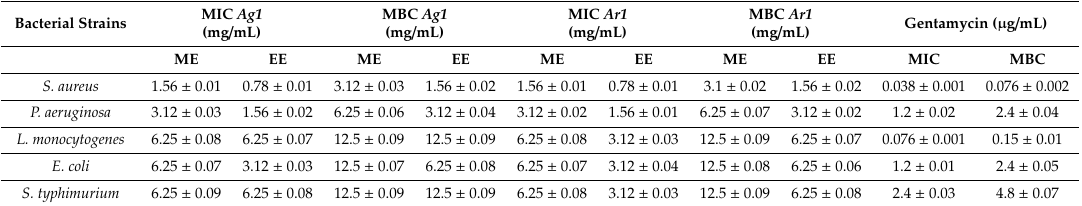
Table 6. Antibacterial activity of A. genevensis ( Ag1 ) and A. reptans ( Ar1 ) extracts. Bacterial